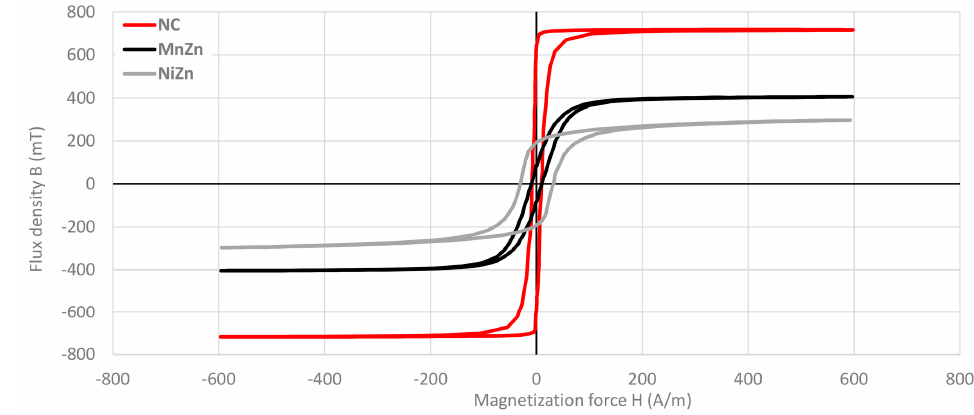
Figure 5. Hysteresis curve measured for NC, MnZn and NiZn cable ferrites.